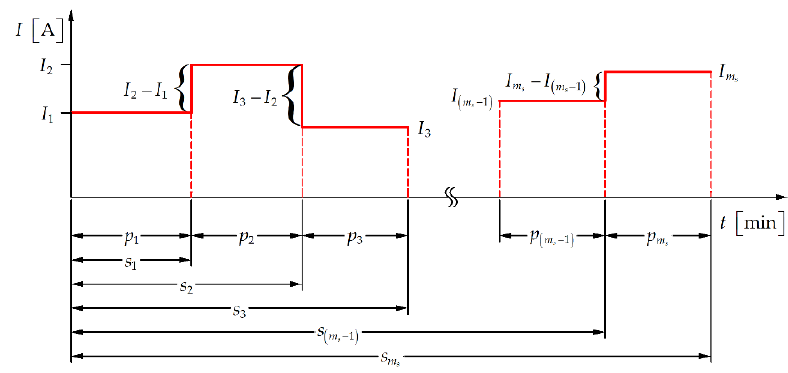
Figure 2. Generalized duty cycle for the autonomous operation of a LAB.